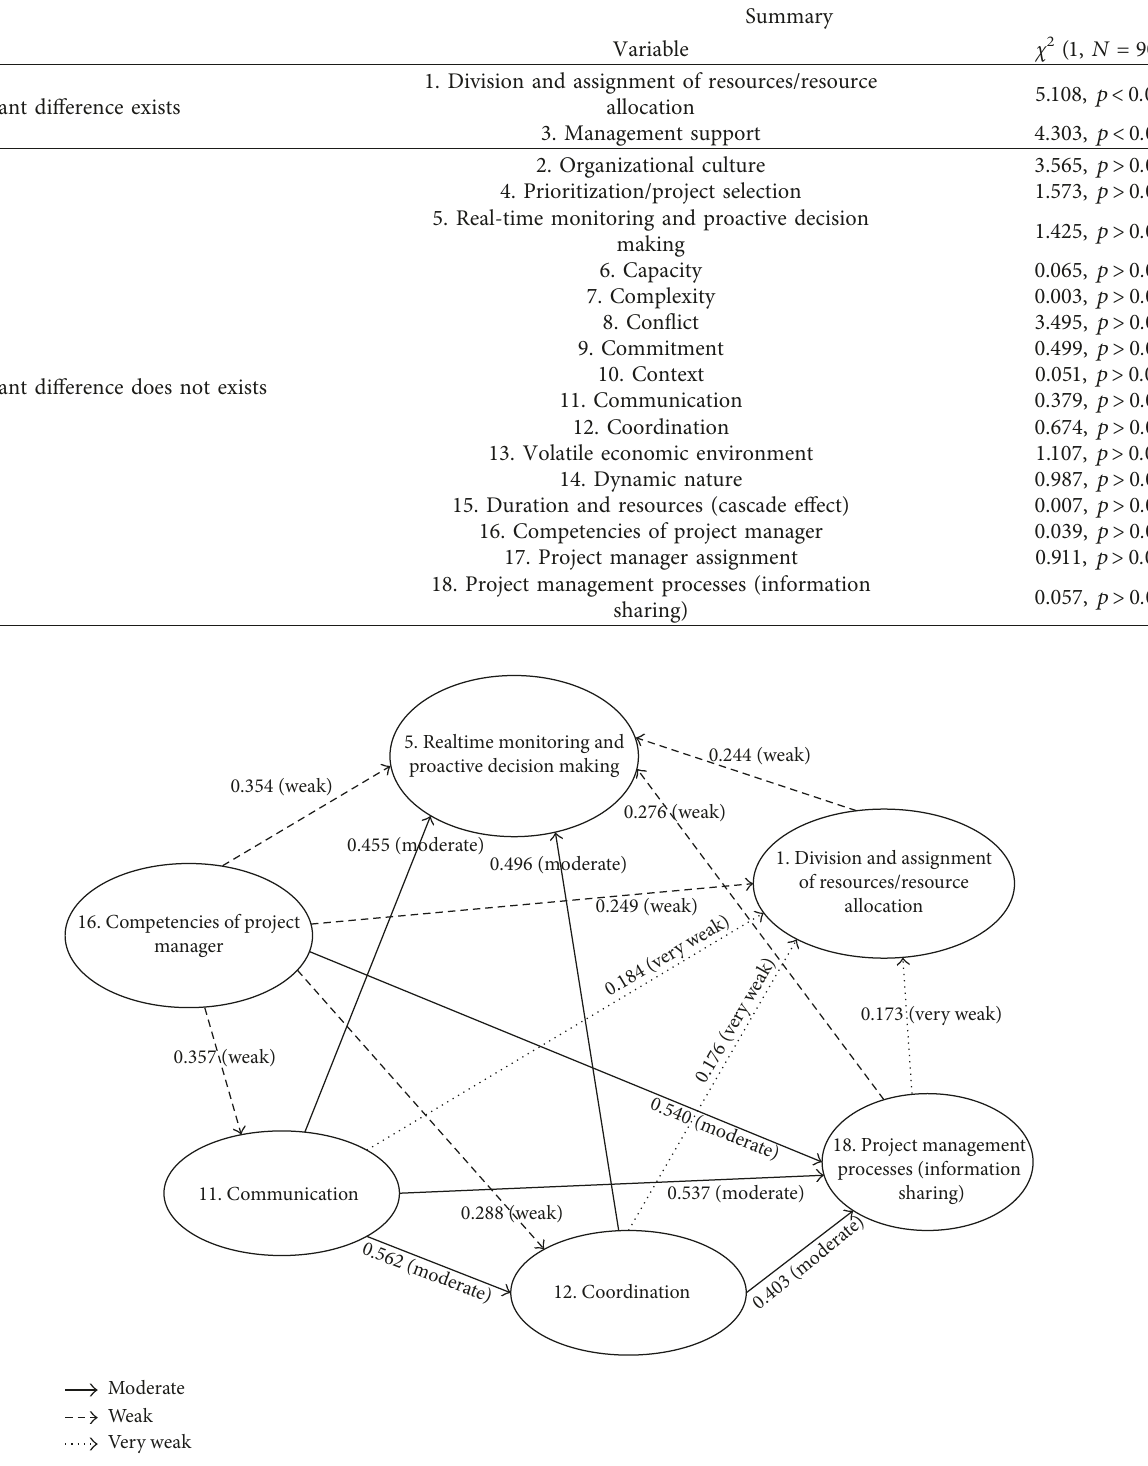
Figure 2: Spearman’s rank correlation relations among the top six coefficient values between 0.284 and 0.575. The variables communication, coordination, conflict, real-time monitor-